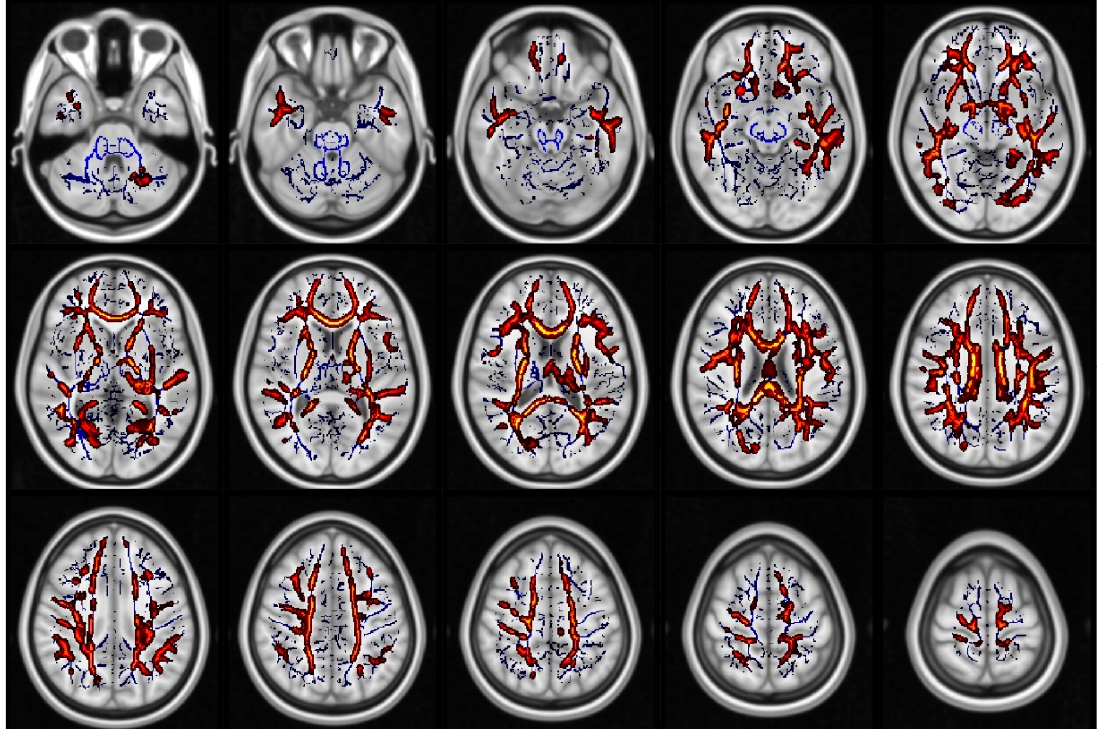
Figure 4. Regions which displayed significant differences in radial kurtosis (RK) (displayed as red and yellow) (CTRL) > glaucoma group (GLA)). The white matter skeleton is shown in blue.